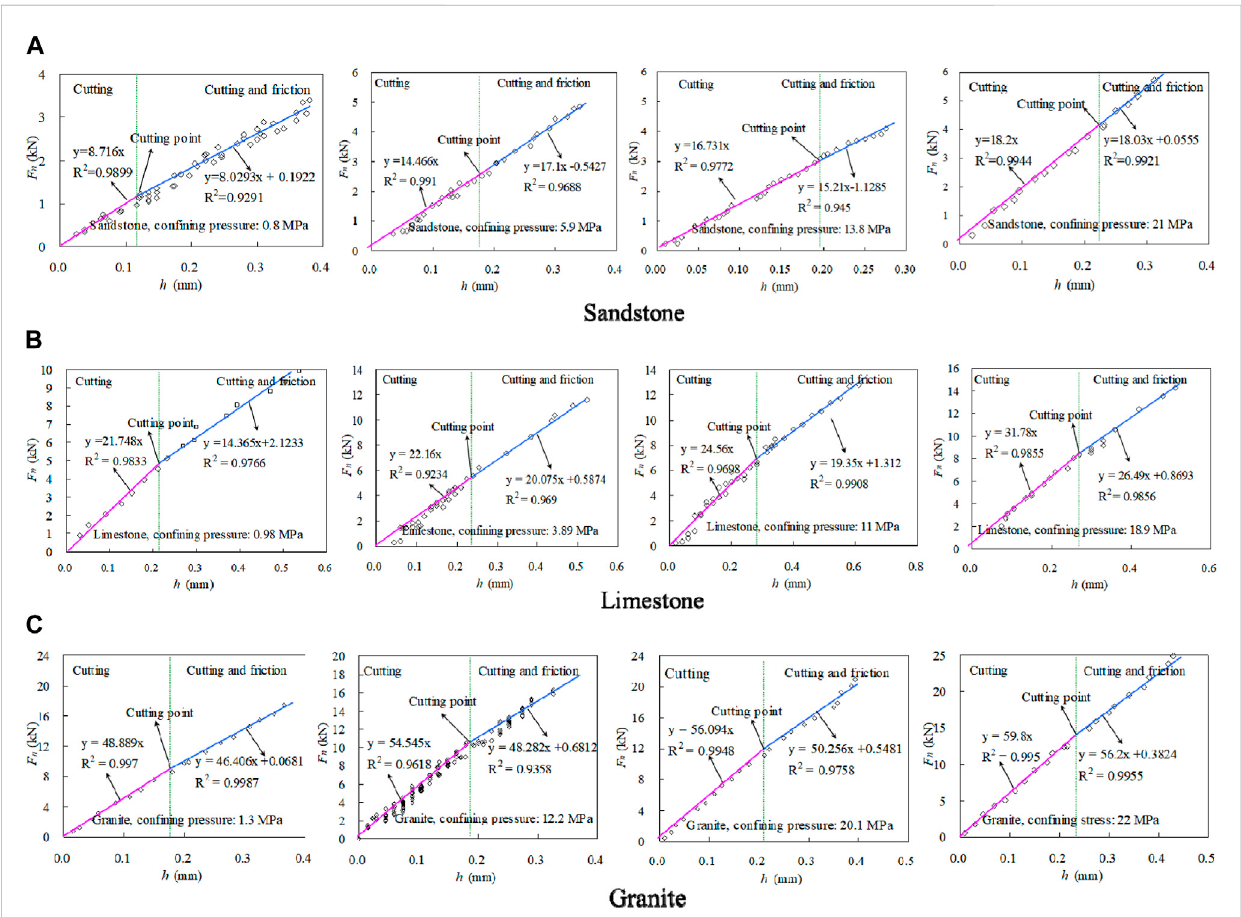
FIGURE 4 Plot of thrust force as afunction of penetration depth per rotation at four different con fi ning stresses. (A) Sandstone, (B) Limestone, and (C)